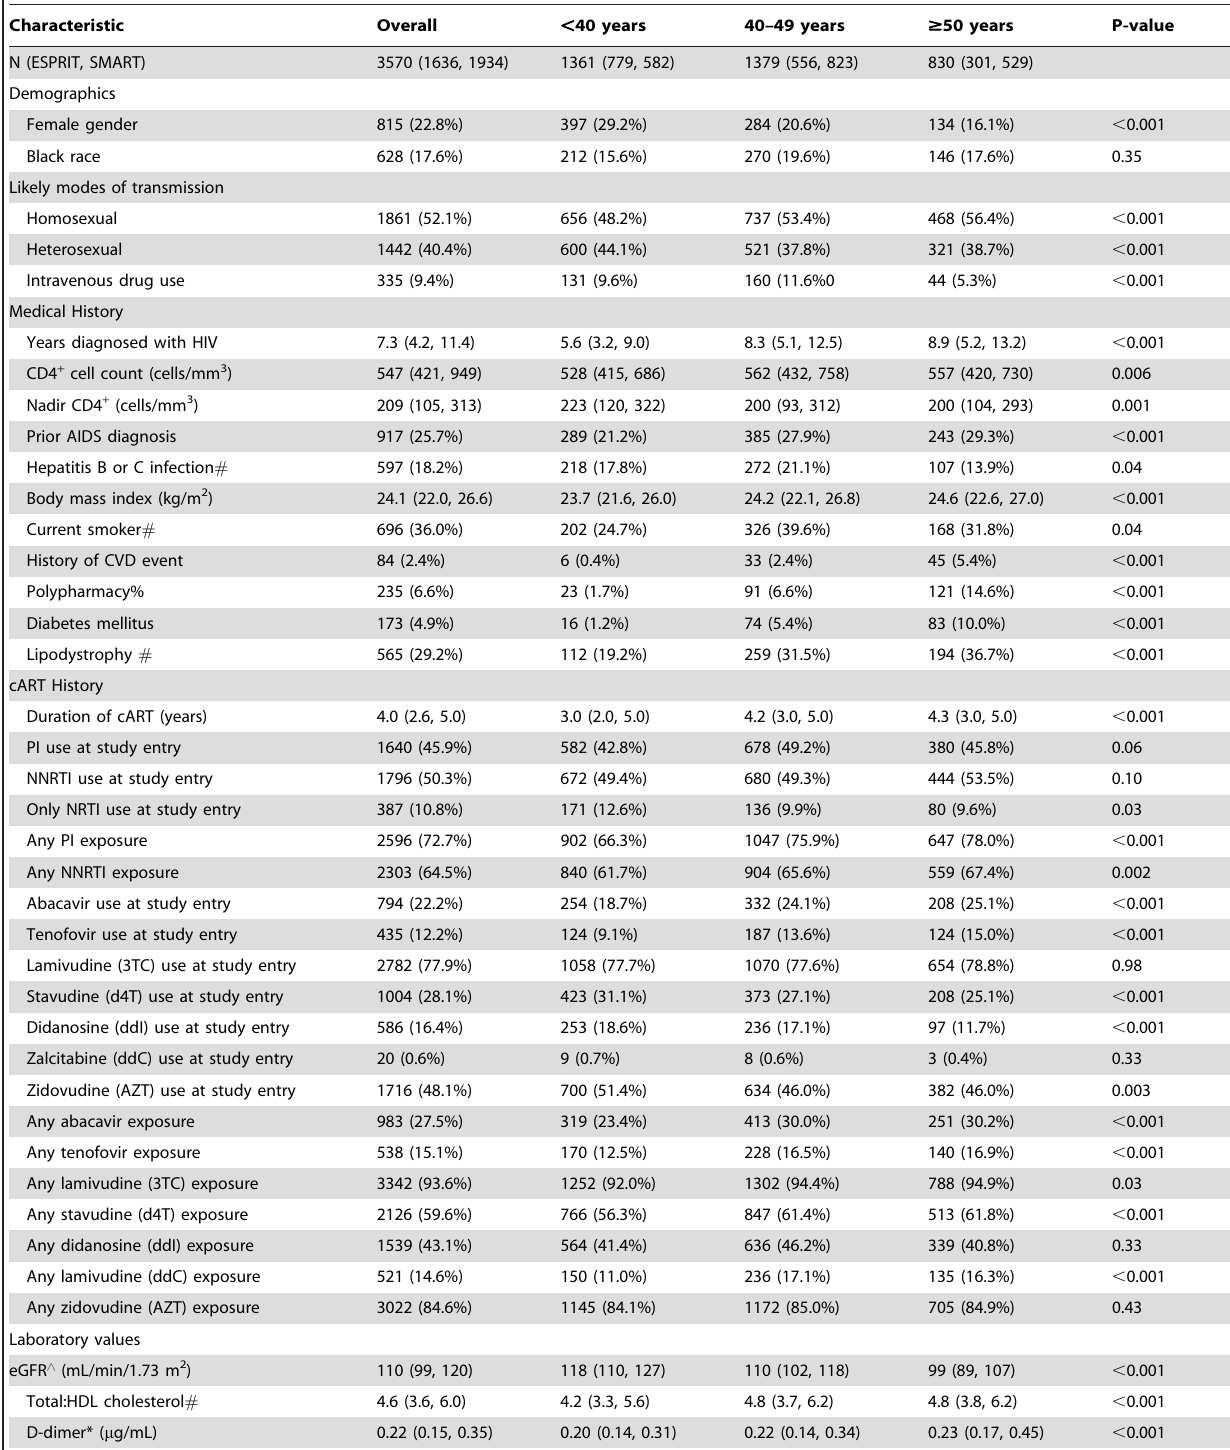
Table 1. Participant characteristics at study entry overall by age